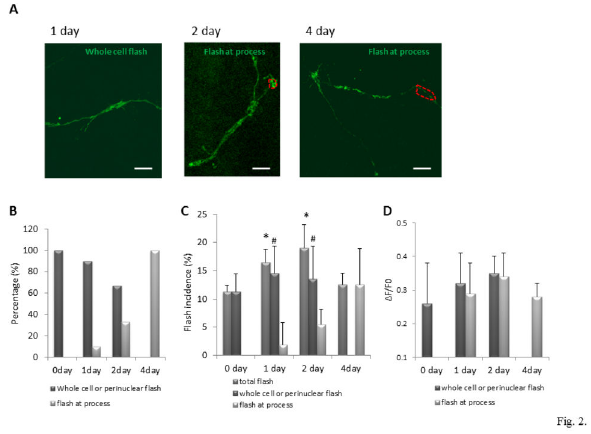
Figure 2. Characterization of mitochondrial SO flashes in NPCs during differentiation. (A) Distribution of mitochondrial SO flashes in NPCs at different days of differentiation. Left, middle and right panels show typical flashes (high intensity fluorescence) in mitochondria of cells on differentiation days 1, 2 and 4. See Movies S1 and S2 for a dynamic view of the superoxide flashes. Bar = 5 µm. (B) Flash pattern changes during NPC differentiation indicated by percentages of flashes occurring in mitochondria throughout the whole cell, in perinuclear regions or in processes/neurites, among all flashes detected. n=60-100 flashes (from four independent cultures) analyzed on each individual day of differentiation. (C) Flash incidence in NPCs during cell differentiation. Flash incidence refers to percentage of cells exhibiting mitochondrial superoxide flashes among all cells scanned during the imaging period (n=4 independent experiments and approximately 150-210 cells scanned per experiment on each individual day of differentiation). Values are expressed as mean ± SD. *p<0.05 vs. total flash incidence of NPCs at day 0; #p<0.05 vs. incidence of flashes in whole cell or perinuclear region at day 0. (D) Flash amplitude (ΔF/F0) in NPCs during differentiation. Flash amplitude was calculated as the ratio ΔF /F0. ΔF indicates difference between peak fluorescence intensity and basal fluorescence intensity. F0 refers to basal fluorescence intensity. Values are expressed as mean ± SD. 60-100 SO flashes (from 4 independent experiments) analyzed on each individual day of